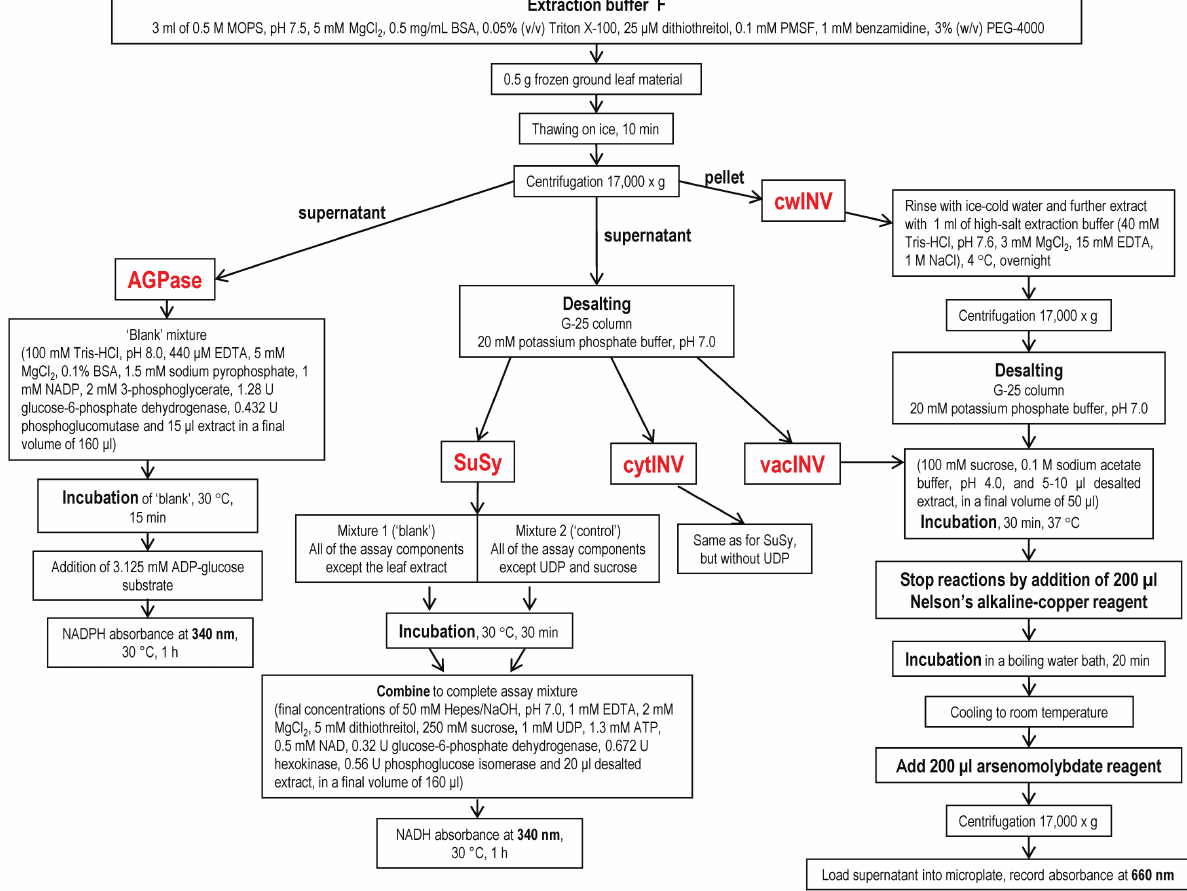
Figure 1. The workflow for measuring enzyme activities of AGPase, SuSy, cytINV, cwINV and